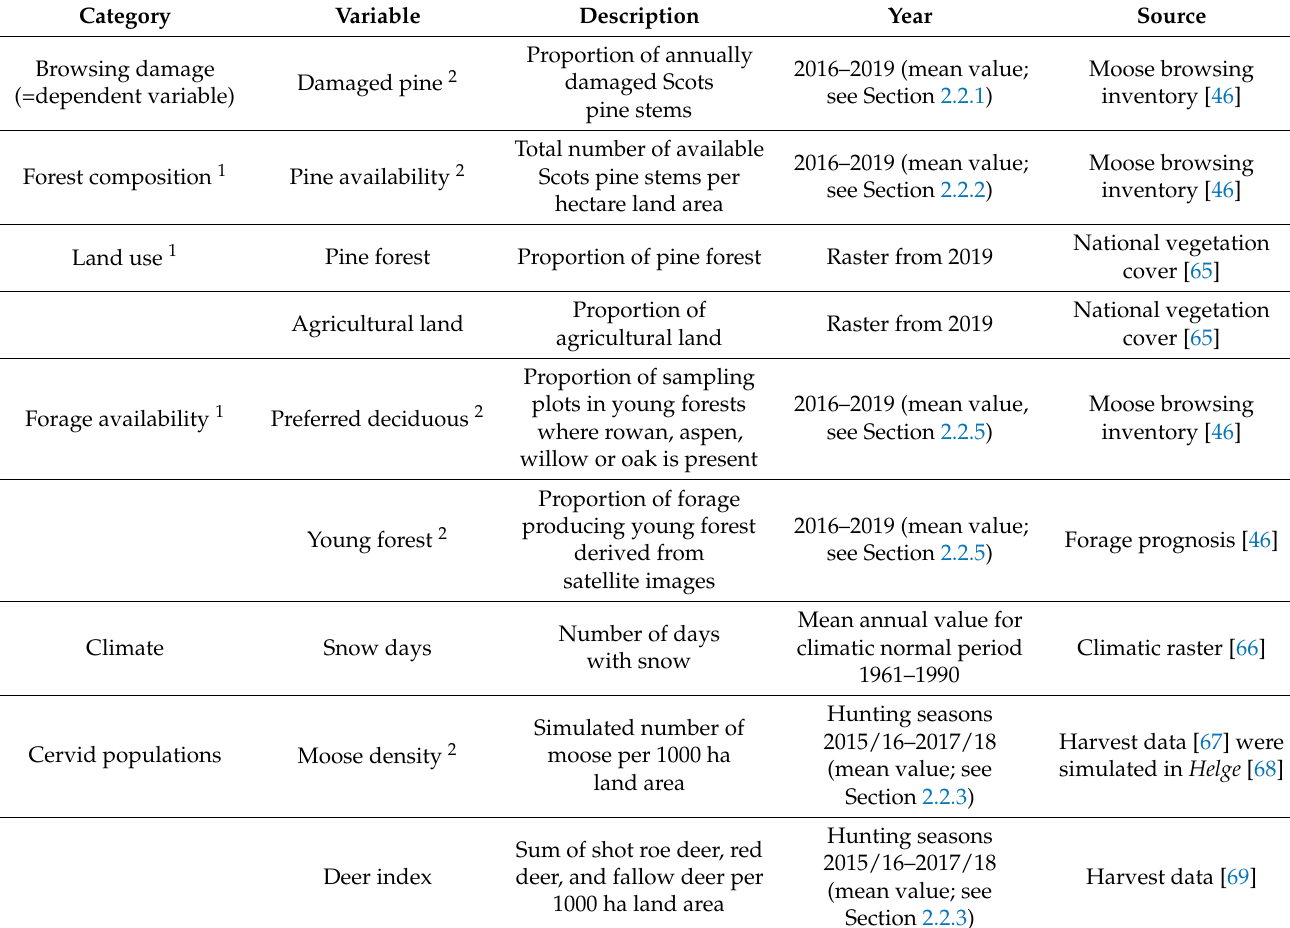
Table 1. Description of variables used in this study. Sample size representing the number of national moose management areas (MMAs) with available data was 144 for all